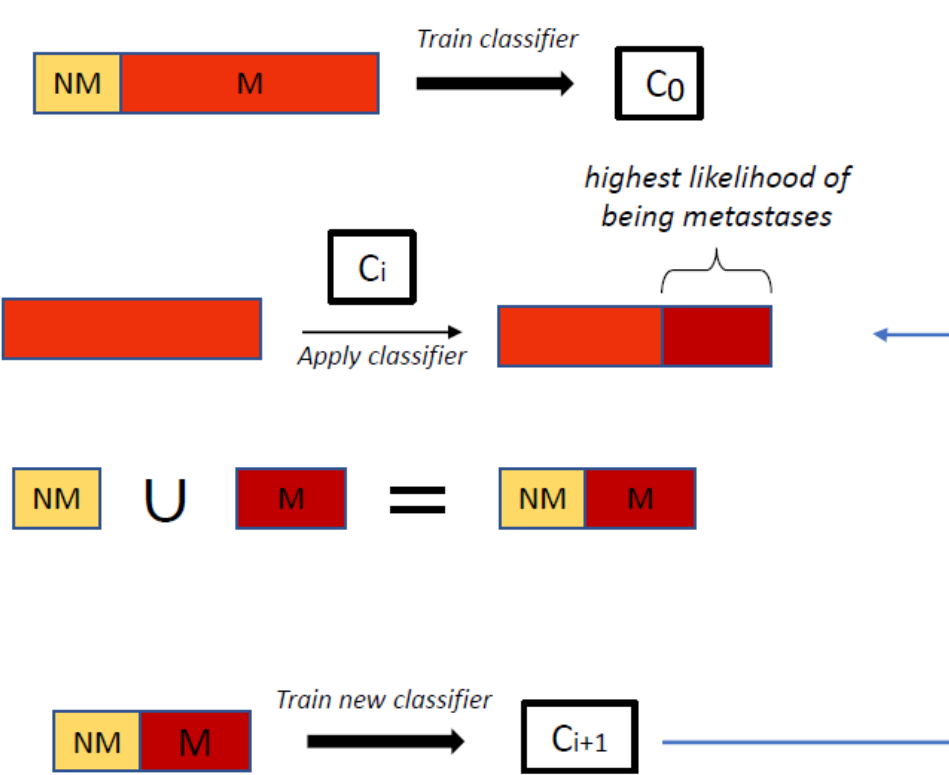
Figure 1. hotBSI algorithm. NM stands for detections labeled as nonmalignant, while M stands for detections labeled for training in a given iteration as